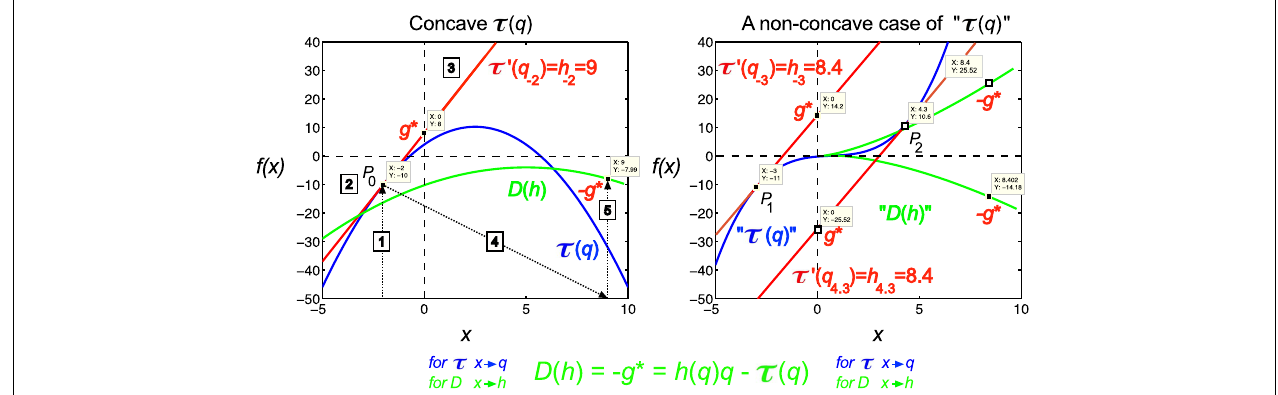
is valid since for any other point on the blue curve, a line drawn through that point with the same slope as the red line will yield a τ 0 -intercept below the point (0, g *), showing that g * is indeed obtained as a boundary value (maximum), thus the transformation for D ( h ) would also yield a single boundary value (minimum) on the green curve as D ( h ) =− g * = τ (cid:48) ( q ) q − τ ( q ). Steps of the transformation process are shown (1) select q , (2) read τ ( q ), (3) take a tangent line at ( q , τ ) and determine its slope, h = τ (cid:48) ( q ), (4) select h , (5) determine D ( h ) using the above equation; repeat for the set. On the right side, a non-concave function is shown (blue) for demonstrating a case, when due to the non-concave shape of τ ( q ) the shape of the transformed function, D ( h ), does not yield a realistic singularity spectrum given that in this case the transform by failing on minimization is poorly behaved yielding ambiguous